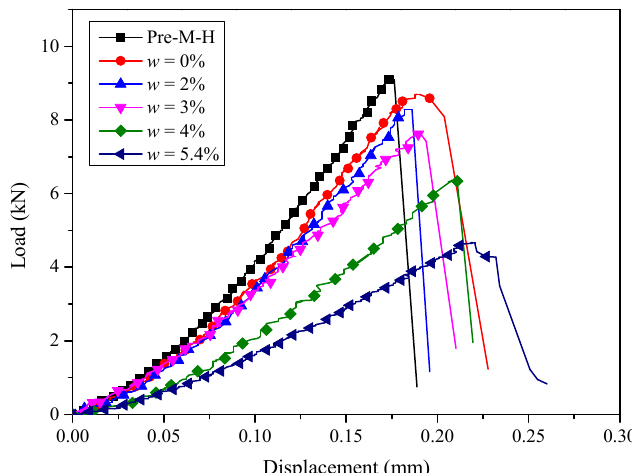
Figure 17. Static Brazilian tests: load–displacement curves of sandstone with different initial water content after microwave irradiation.